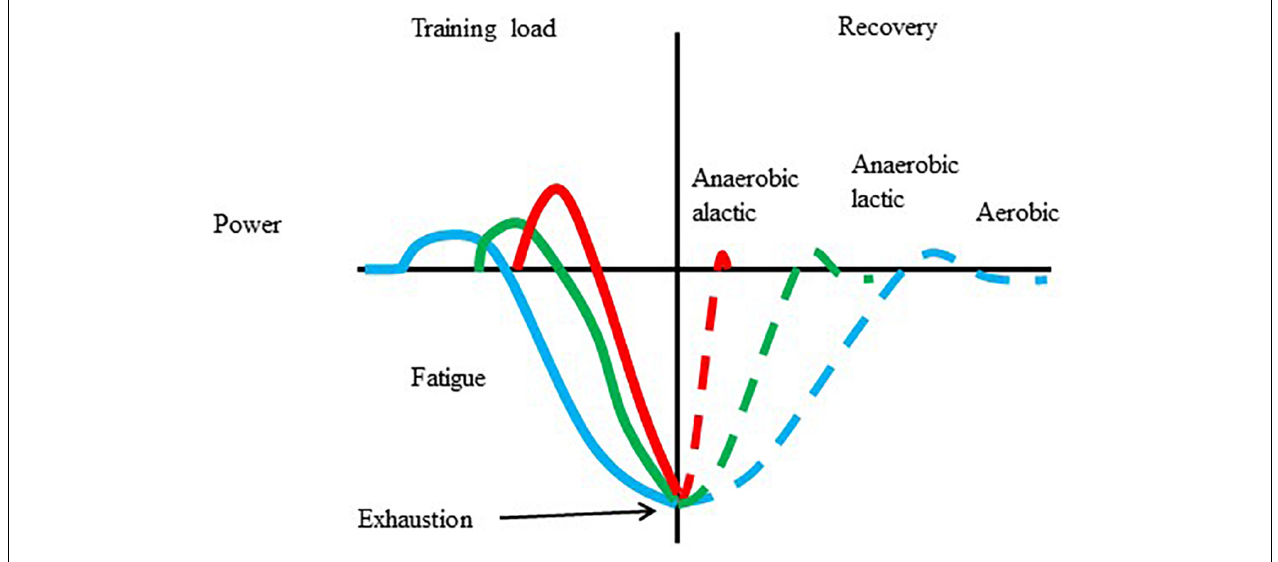
FIGURE 1 | Adaptation to a single bout of exercise. Exercise results in increased metabolism, and power, which, after repeats can lead to fatigue and exhaustion. The length of recovery is dependent on the type of exercise that caused the fatigue and the level of fatigue. During the recovery periods overcompensation is